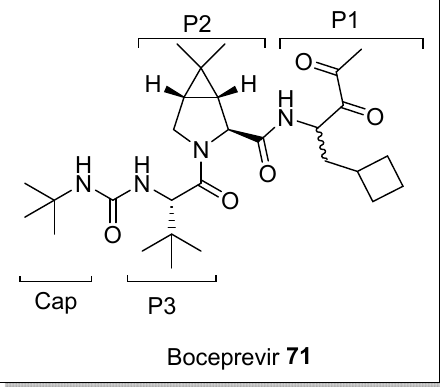
Figure 1. Structure of Boceprevir.